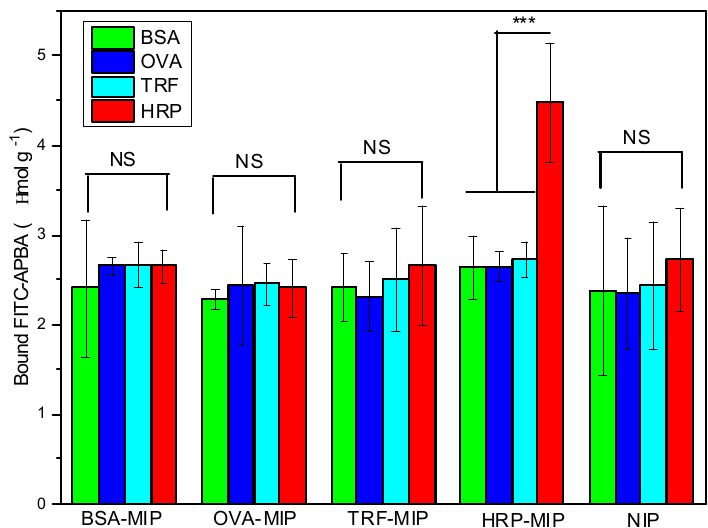
Figure 6. Selective detection of HRP captured by HRP–MIP using BA–FITC conjugate. The different imprinted nanoparticles (BSA–MIP, OVA–MIP, TRF–MIP and HRP–MIP) and NIP nanoparticles were first incubated separately with the four proteins before being exposed to BA–FITC. The concentration of the different proteins was fixed at 1.0 mg mL − 1 . P values were calculated by one-way